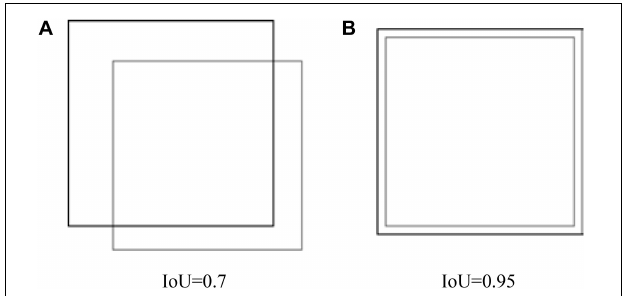
FIGURE 5 | IoU schematic. (A) IoU=0.7. (B)